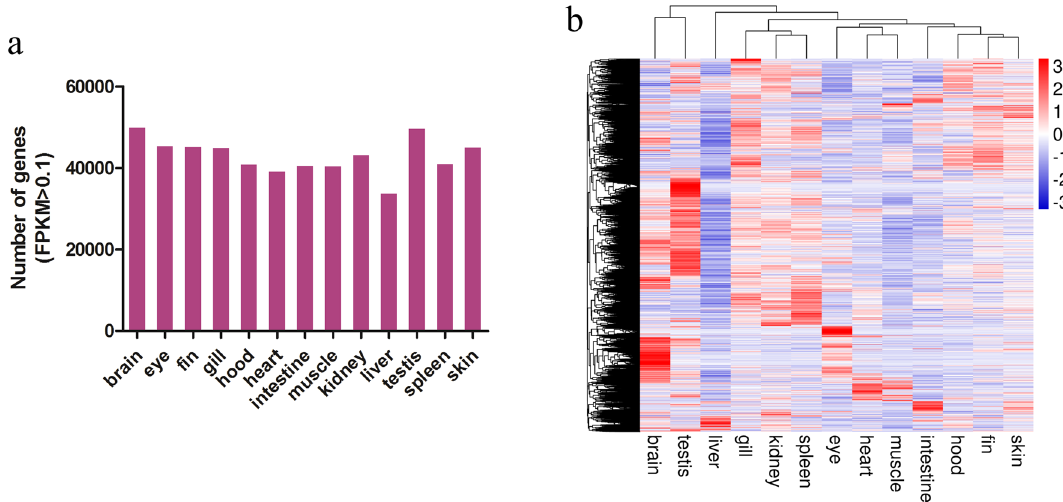
Figure 5. Gene expression profiles of 13 adult goldfish tissues. ( a ) The number of expressed genes (FPKM > 0.1) in each tissue. ( b ) Heatmap of gene expression levels in each tissue. The figures were constructed in Microsoft Office Excel and pheatmap R package 1.0.12 (https ://CRAN.R-proje ct.org/packa ge=pheat